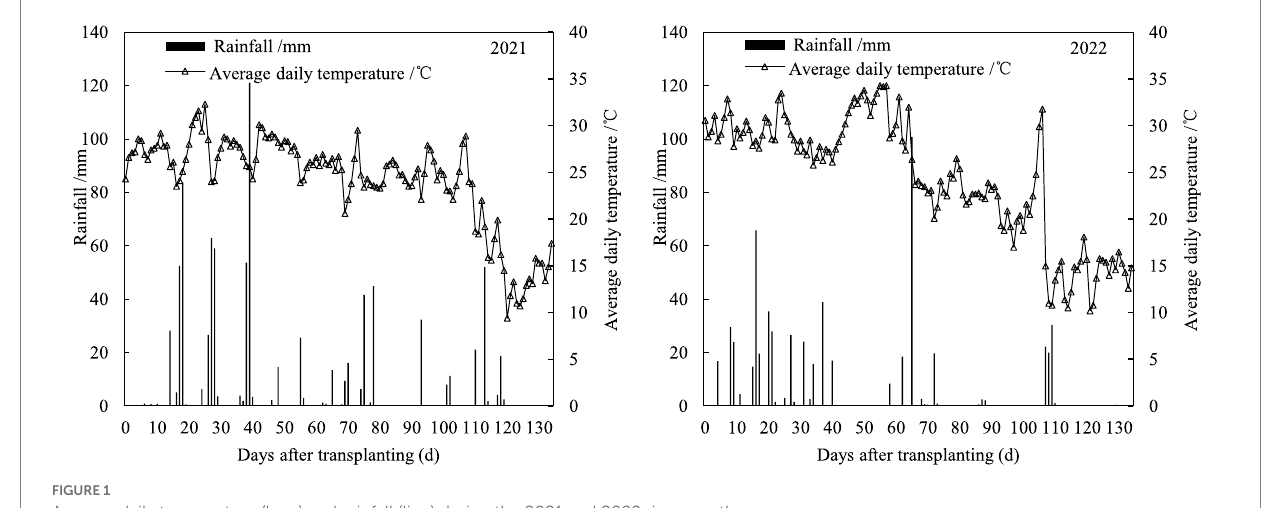
FIGURE 1 Average daily temperature (bars) and rainfall (line) during the 2021 and 2022 rice growth season.